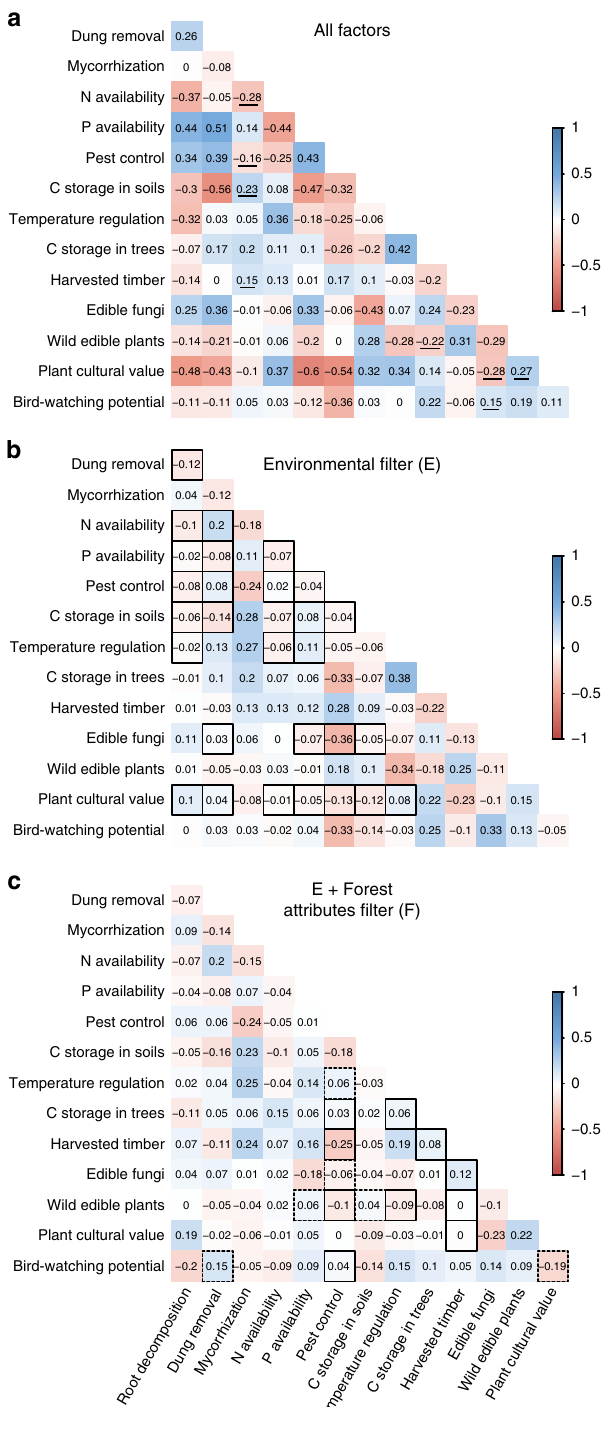
Fig. 3 Details on the synergies and trade-offs between ecosystem services. Panel a shows the individual Pearson correlations between pairs of ecosystem services. Consistent ( r ≥ |0.1|) synergies and trade-offs across the three correlation matrices (All factors, E and F) are underlined. Panel b shows the correlations after removing the effect of environmental factors (E). Those correlations driven by environmental factors (i.e. those signi fi cantly different from the original correlations, panel a vs. panel b ) are in solid line boxes. Panel c shows the correlations after removing the effect of both environmental factors and forest attributes (F). Those correlations driven by the forest attributes alone (i.e. signi fi cantly different from the correlation with only environment effects removed, panel b vs. panel c ) are in solid line boxes, and those driven by a combination of the environmental factors and forest attributes (i.e. signi fi cantly different from the original correlations (panel b vs. panel d ) but not from those with environmental effects removed (panel c vs. panel d )) are in dashed line boxes. See Supplementary Fig. 4 for the changes in correlations caused by